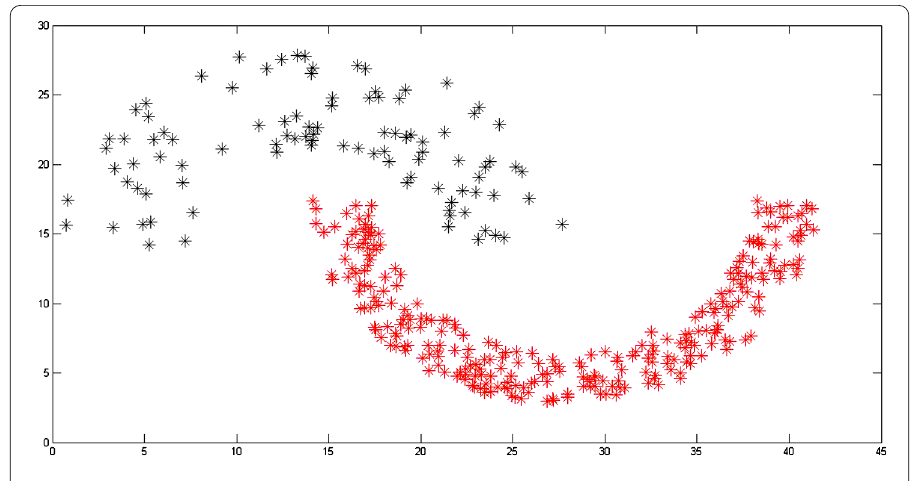
Figure 2 Two-moon data set.